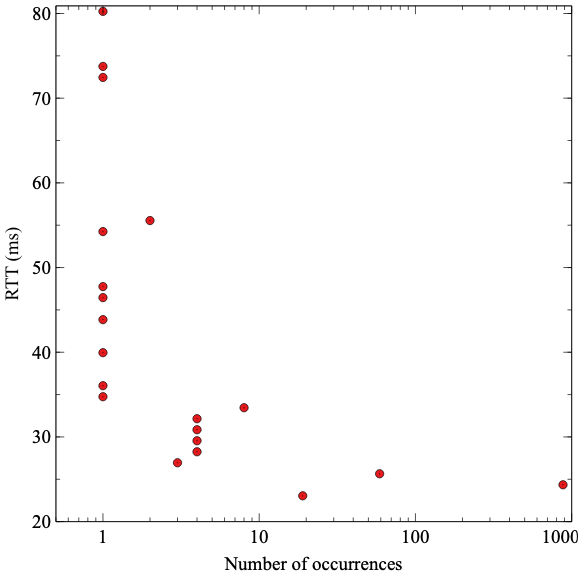
Figure 10. Histogram of latency measurements of ICMP Echo requests from sensor to the cloud broker.